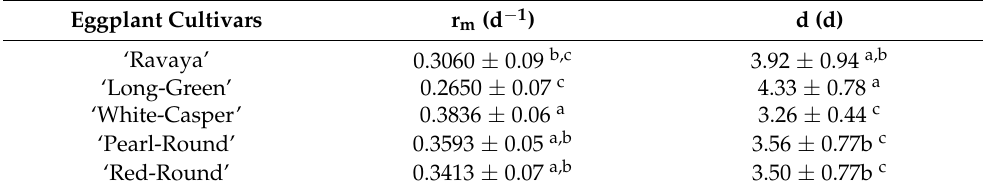
Table 3. Mean ( ± SE) of intrinsic rate of population increase (r m ) and developmental time (d) of Myzus persicae on five eggplant cultivars in the greenhouse